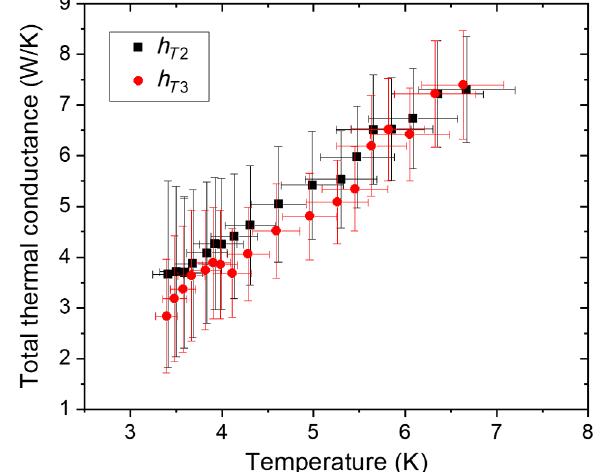
FIG. 29. Total thermal conductance between the cavity and CCRs 2 and 3 as a function of temperature obtained from the data measured during the high-power rf test after the second